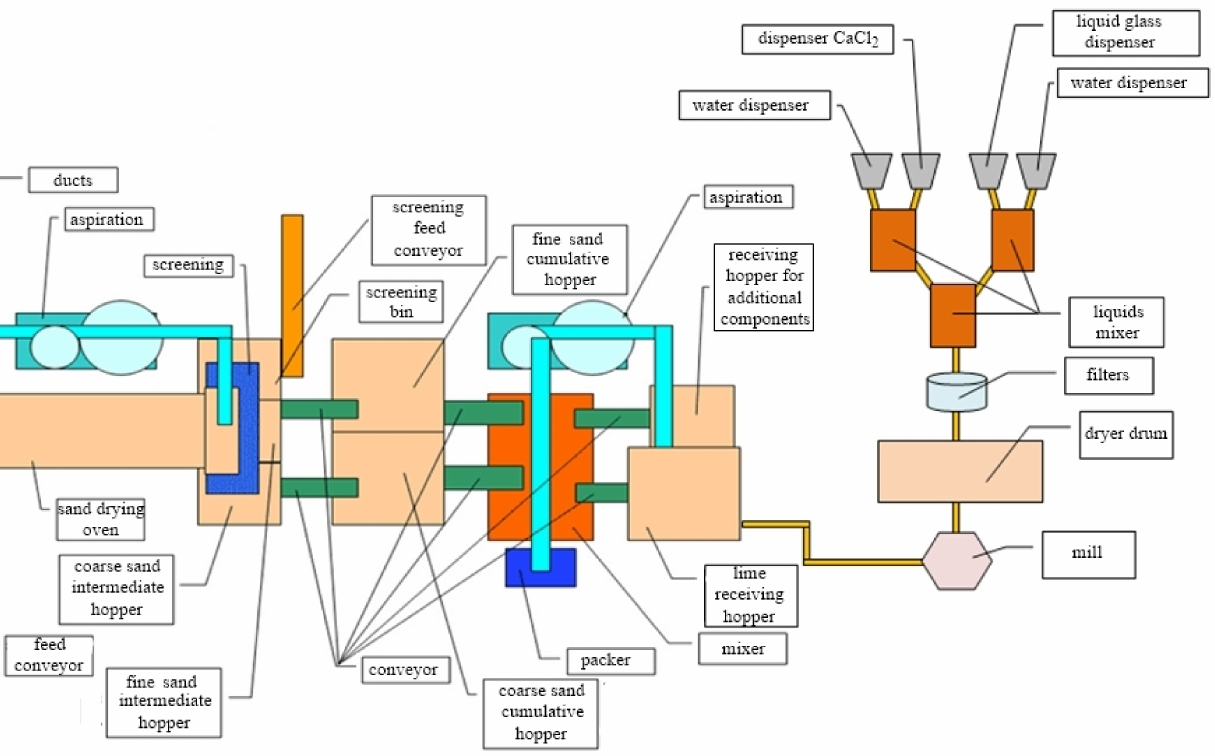
Figure 11. Technological scheme for the production of lime dry plaster